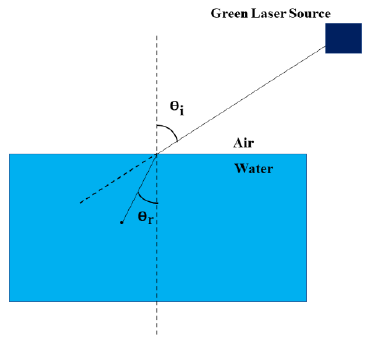
Figure 2. Schematic diagram of refraction of a green laser in water.